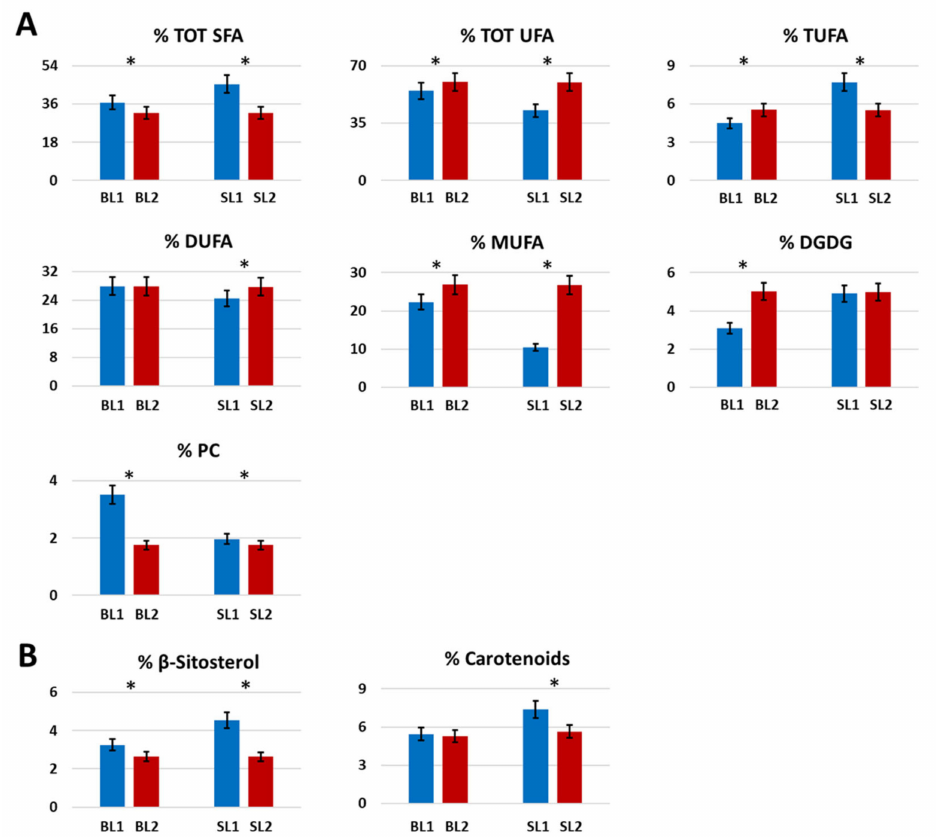
Figure 3. Histograms resulting from the quantitative NMR analysis of some metabolites present in the Bligh-Dyer organic extracts of Goji berries cultivars Big Lifeberry (BL) and Sweet Lifeberry (SL) harvested in August (1) and October (2). ( A ) fatty acids and polar lipids, ( B ) Other metabolites. Results were expressed as molar % ± SD. * p < 0.05 significantly difference between the two harvesting periods in the same cultivar, one-way